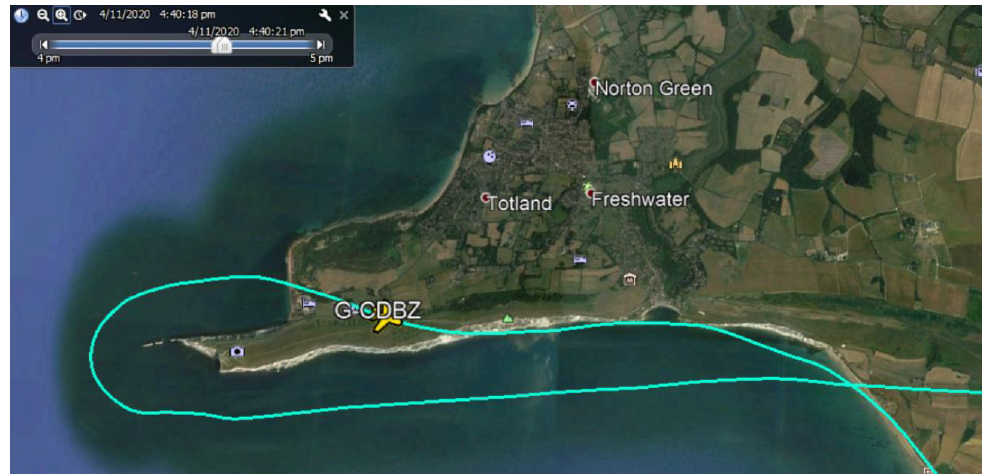
Figure 13. A screenshot of the historical data